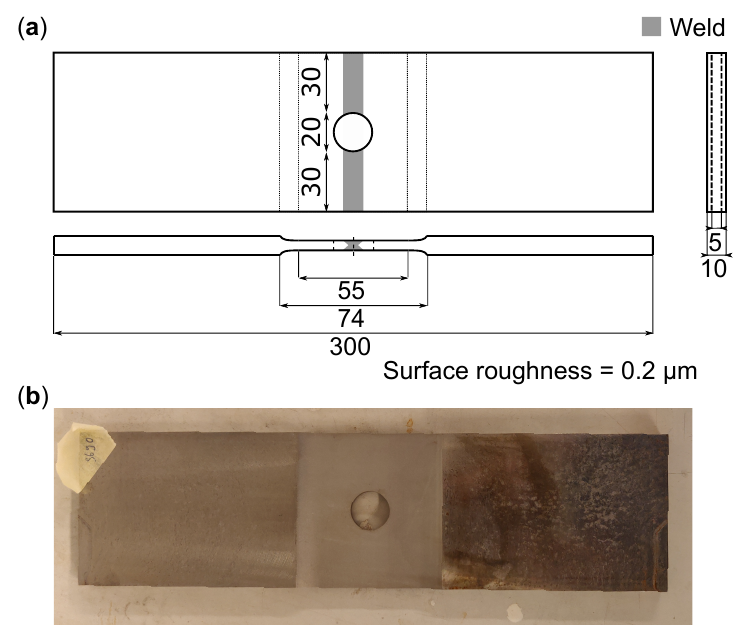
Figure 3. Test specimen used in the validation experiments: ( a ) dimensions of the flat specimen, and ( b ) manufactured flat specimen. The dimensions are provided in mm unless stated differently. The schematic is not drawn to